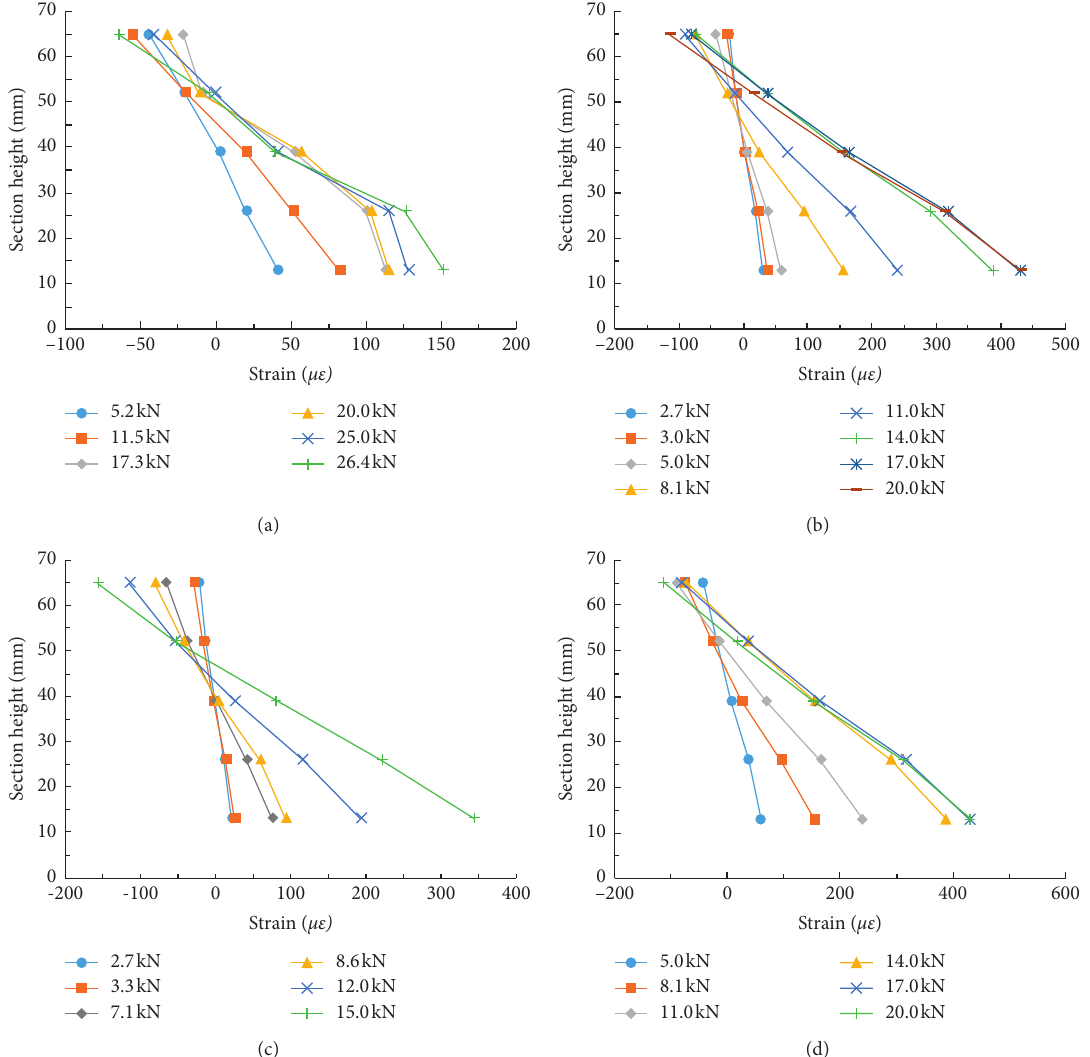
Figure 7: Variation law of strain of midspan section in top slab of various BCs. (a) Flat seam type. (b) Round hinged type. (c) Integral type. (d) Mortise type.